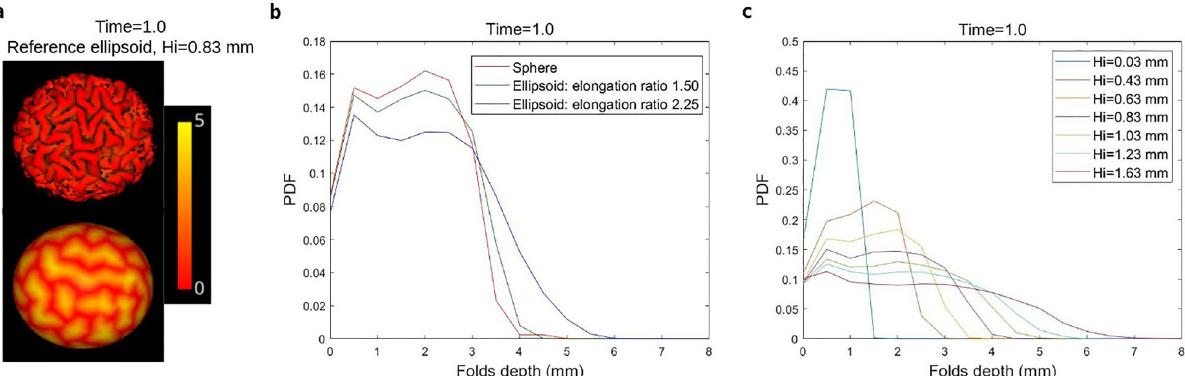
Figure 7. The effect of initial geometry and initial cortical thickness ( H i ) on sulcal depth. ( a ), visualization of sulcal depth at time 1.0 on the deformed and corresponding initial reference ellipsoid with the initial cortical thickness 0.83 mm, ( b ), probability density function (PDF) of sulcal depth at time 1.0 for different initial geometries, ( c ), PDF of sulcal depth at time 1.0 for different initial cortical thicknesses. Software: ( a ), Visbrain-0.4.5, http:// visbr ain.